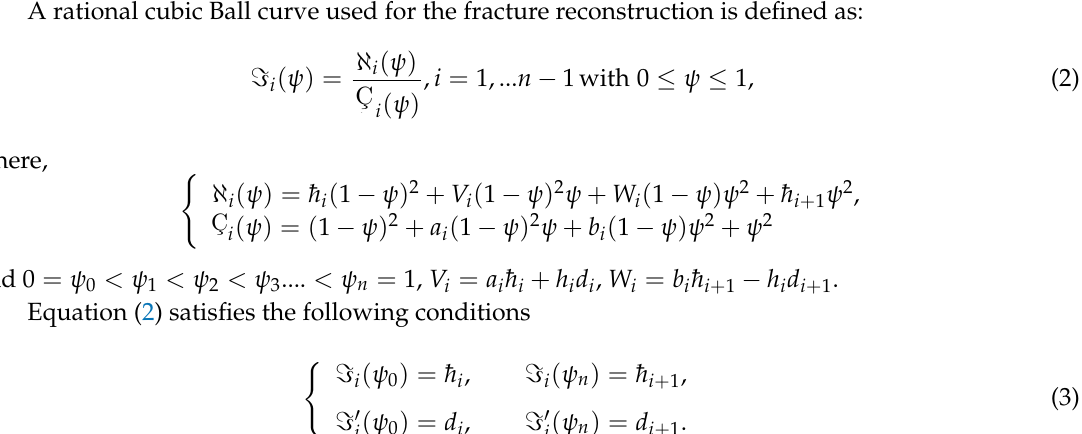
Figure 3. Variation diminishing property with b = 1 p = 3 k = 1.